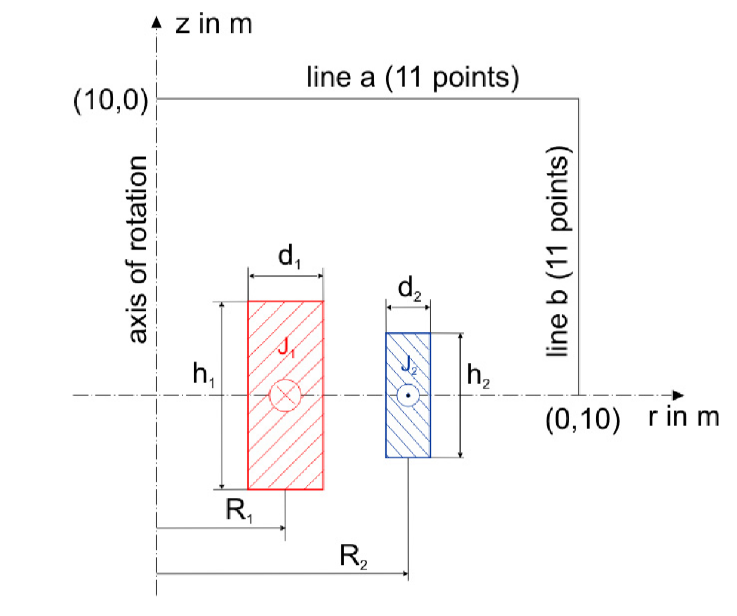
Figure 4. SMES Device [15]. Table 3. Bounds of design variables for TEAM problem